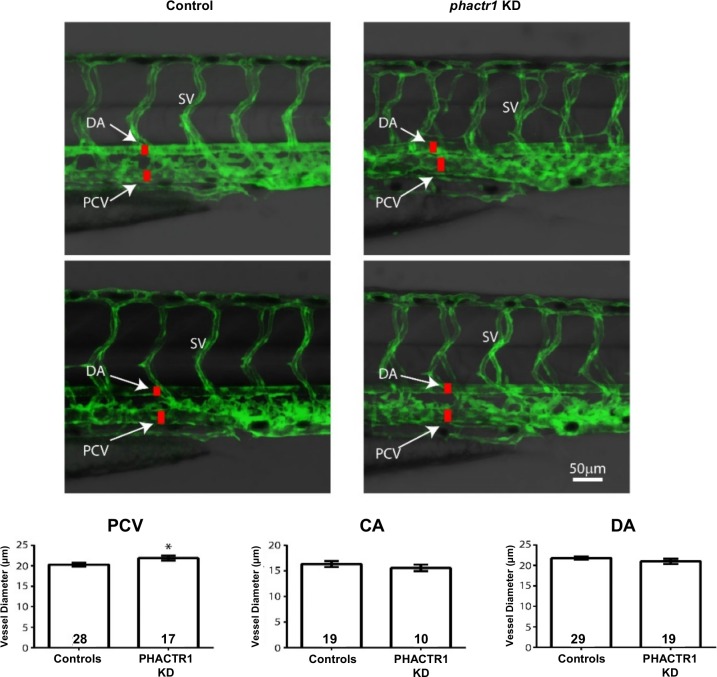
phactr1 modulation in zebrafish affects vascular dimensions and patterning.Two-dimensional projections obtained from z-series confocal images in the trunk of control and phactr1 knockdown (KD) zebrafish embryos (two representative images per condition). Green represents the vascular endothelium as marked by EGFP. Greyscale represents the corresponding DIC bright field image of the fish trunk. DA: Dorsal aorta, SV: Segmental vessel, PCV: Posterior cardinal vein. Quantification of inner vascular diameter for the dorsal aorta (DA), posterior cardinal vein (PCV) and caudal artery (CA). (*) represents P<0.05.